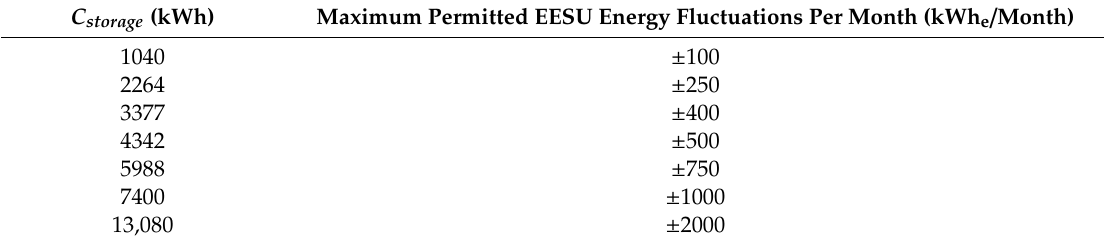
Table 3. Calculated electrical storage capacity for each